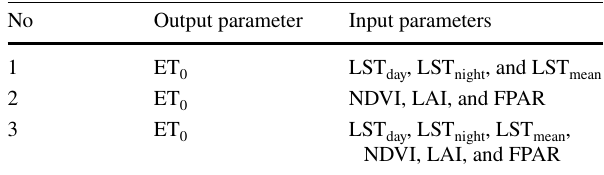
Table 6 The number of missing data of day and night LST and